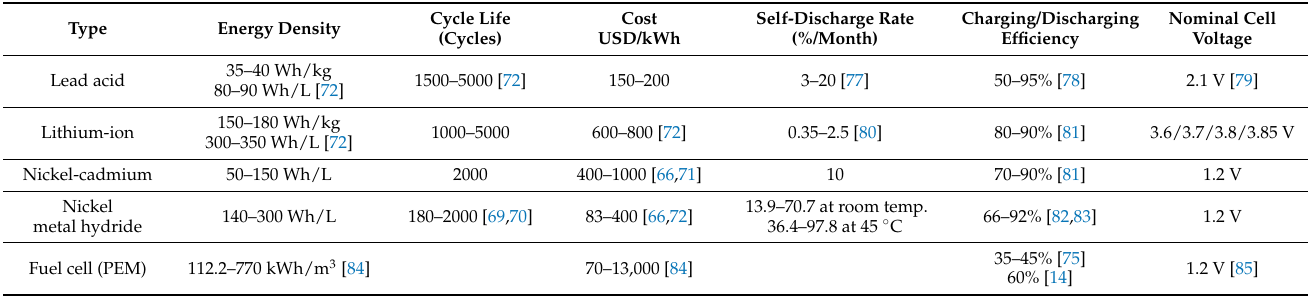
Table 8. Comparison of key features of energy resources used in EV